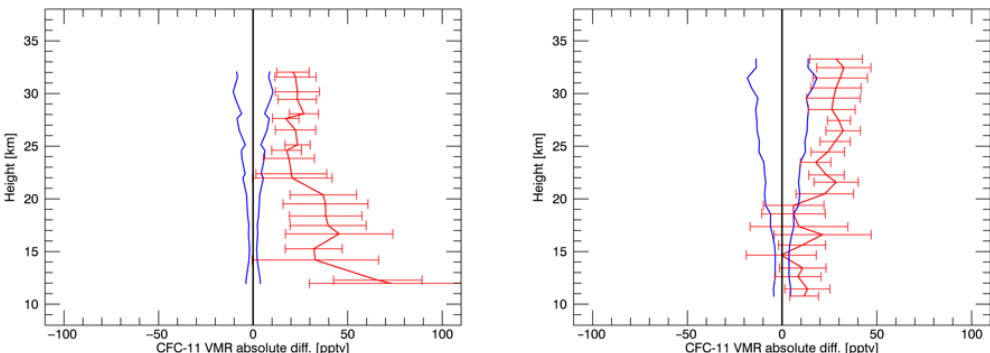
Figure 16. Same as Fig. 4, but instead of CH 4 now